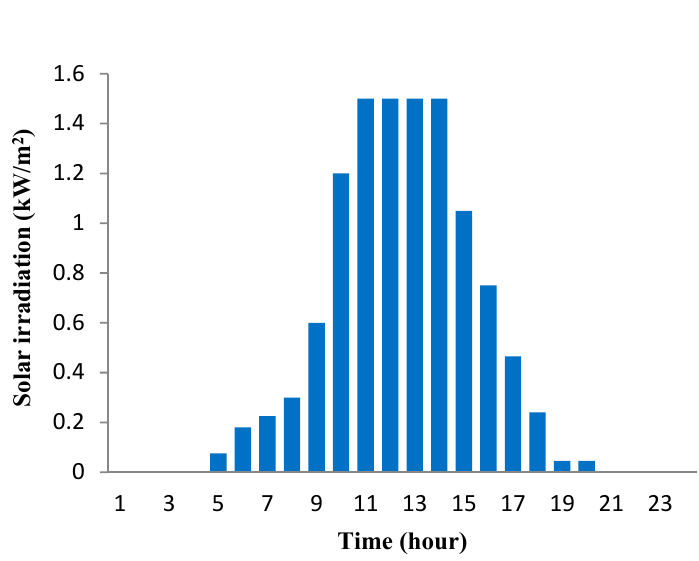
Figure 3. Predicted solar irradiation over a 24 h horizon.